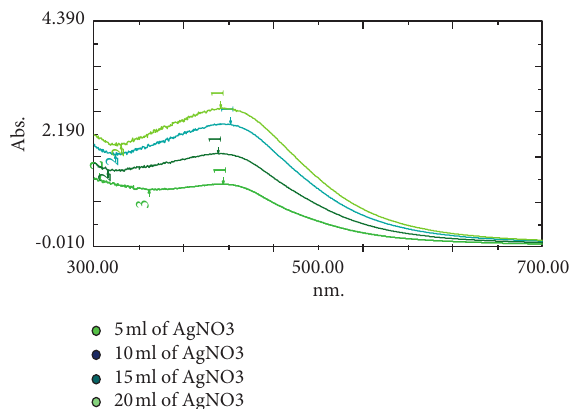
Figure 1: The electronic absorption spectrum of Camellia sinensis silver nanoparticles upon addition of 5ml, 10ml, 15 ml, and 20ml of AgNO 3